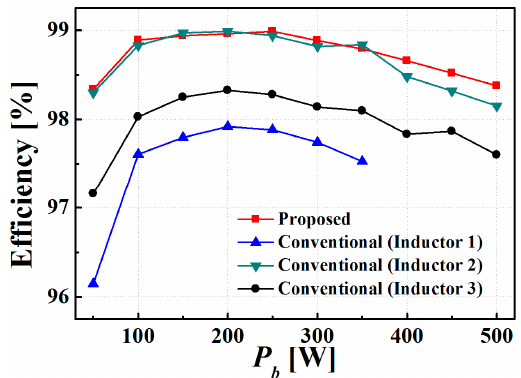
Figure 17. η e vs. P b at V a = 48 V and V b = 60 V.